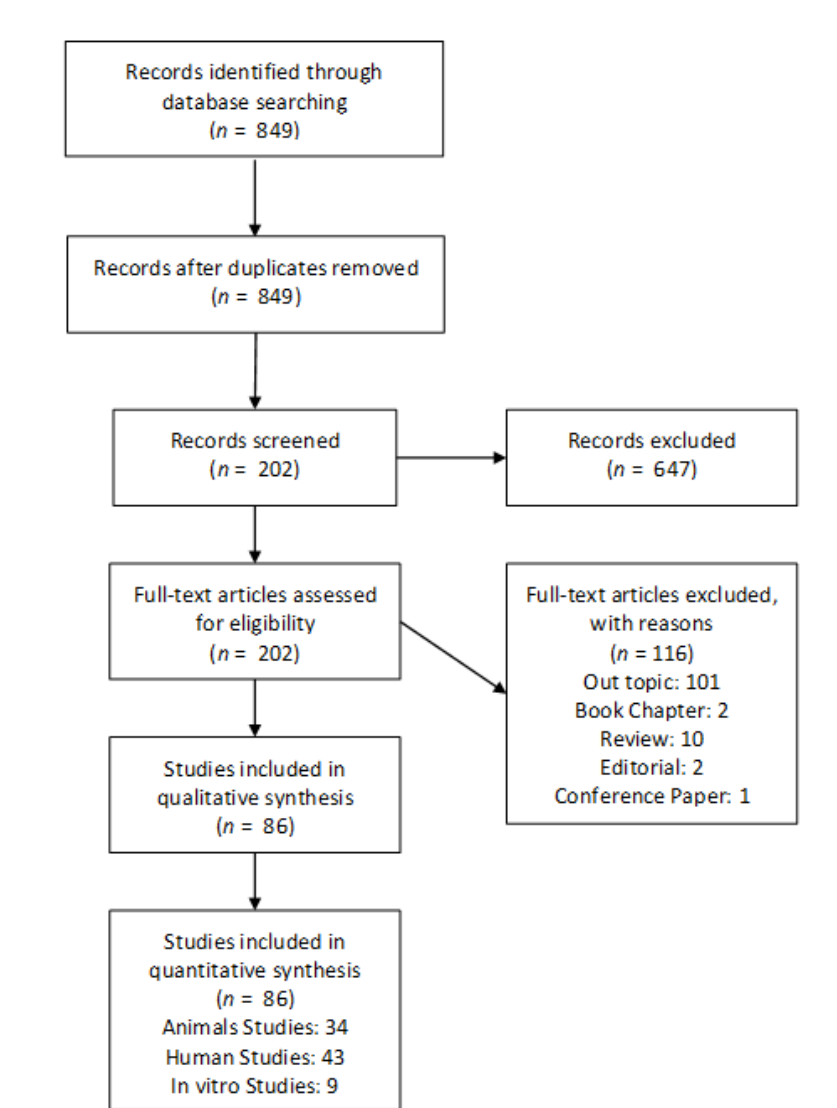
Figure 1. PRISMA flowchart of the included studies.